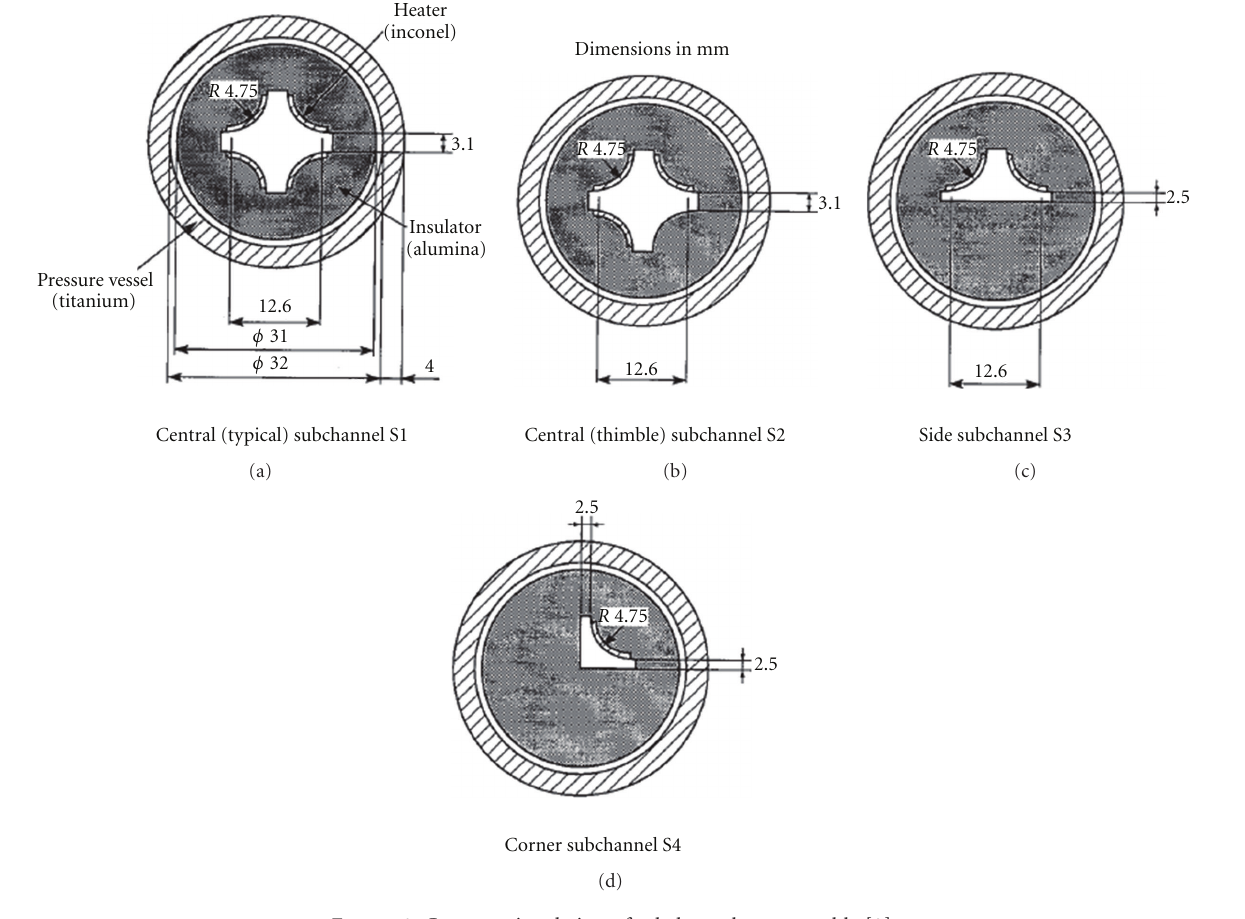
Figure 2: Cross-sectional view of subchannel test assembly [2]. Table 1: Geometry and power shape for single-channel tests [2].